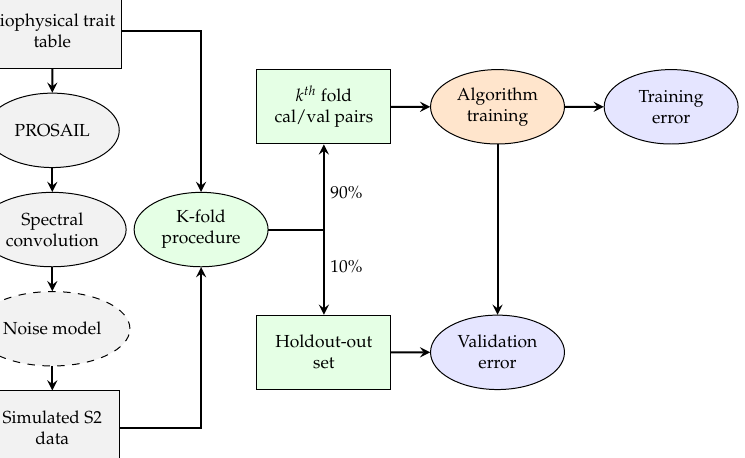
Figure 2. Flowchart representing the training and validating procedure of the experiments. All algorithms were trained with the same data to exclude any random effect. The noise is only added in the second part of the experiment when testing its effect on the